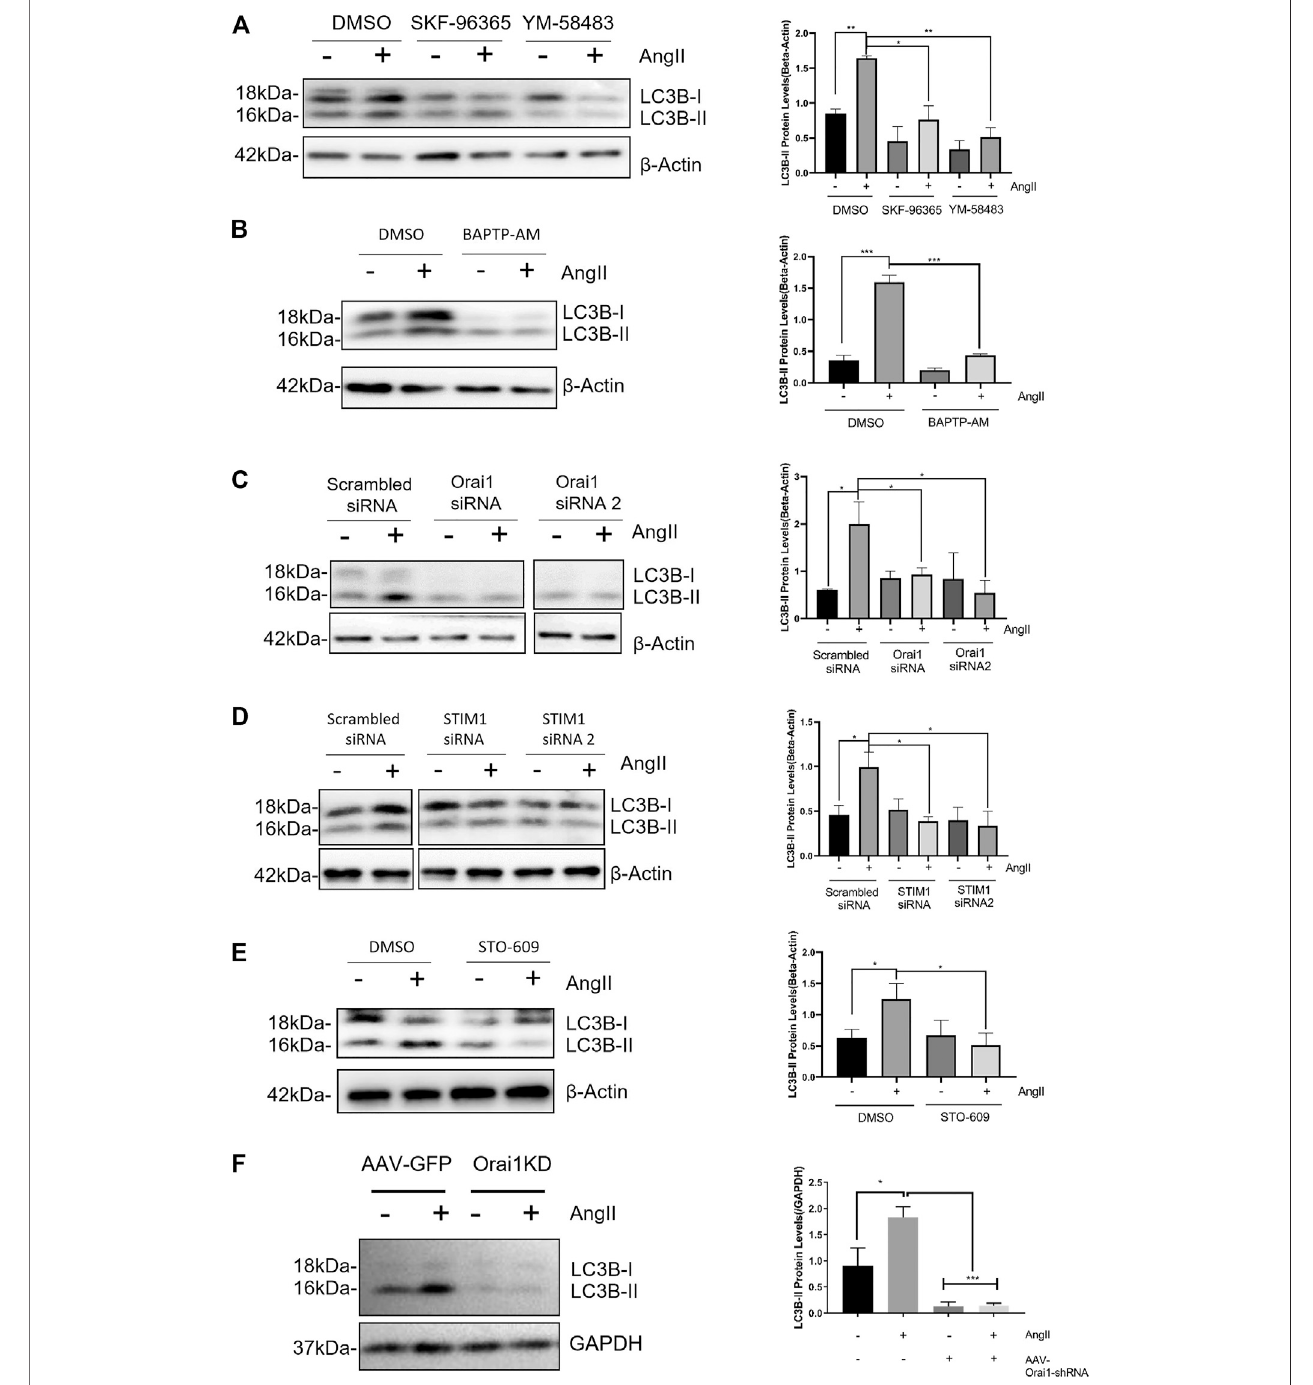
FIGURE 2 | SOCE-calcium-CaMKK is involved in Ang II-induced cardiac autophagy (A) Ang II treatment increased LC3-II expression levels in NRCM, which were blockedbySOCEinhibitorYM-58483andSKF-96365.Therepresentativeimmunoblotsanddatasummaryareshown (B) EffectofintracellularcalciumchelatorBAPTP- AM on LC3-II protein levels in NRCMs. The representative images (left) and data summary of immunoblots (right) are shown (C, D) Representative images and data summary showing that knockdown of Orai1 (C) and STIM1 (D) in NRCM using Orai1-siRNA and STIM1-siRNA respectively attenuated Ang II-induced cardiac autophagy,asindicatedbyLC3-IIlevels (E) EffectofCaMKKinhibitorSTO-609onLC3-IIproteinlevelsinNRCMs.Therepresentativeimages (left) anddatasummaryof immunoblots (right) are shown (F) Continuous infusion of Ang II increased LC3-II protein levels in C57 mice, which were blocked by Orai1 knockdown. The representative immunoblots and data summary are shown. * p < 0.05, ** p < 0.01, and *** p < 0.001.